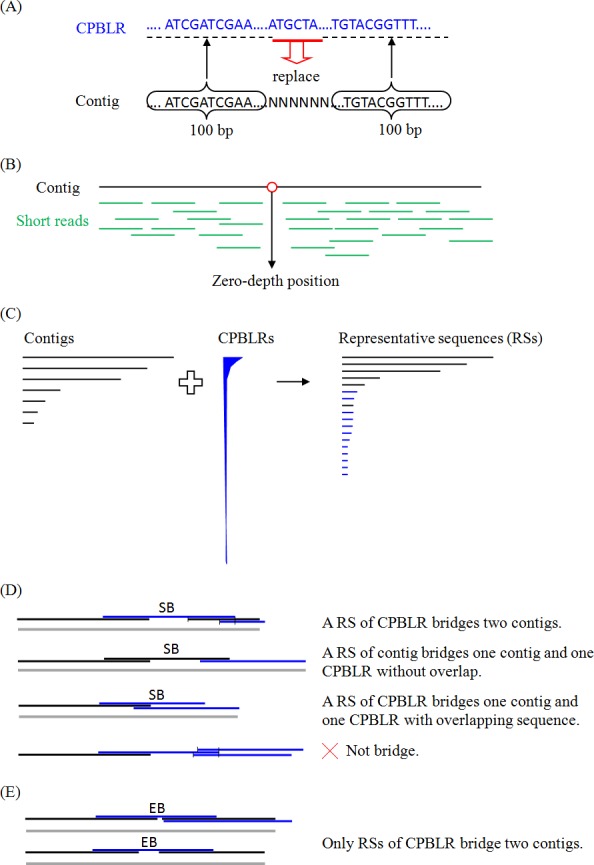
Schematic diagrams of the process flow used in Patch.(A) Gap-filling: a gap (with N’s) is replaced with the corresponding sequence (e.g., ATGCTA). (B) Splitting: A contig is split into two sequences at the zero-coverage position. (C) Representative sequence selection: representative sequences are selected from a modified assembly (contigs in black color) combined with all/15X CPBLRs (in blue color). (D) Strict bridging (SB): a representative sequence (RS) is used for bridging if it uniquely (i.e. the length of end-to-end alignments (as bounded by the vertical bars) is maximal and at least 1.25-fold larger than the secondary choice) aligns to two representative sequences (either one must be a black representative contig). The grey lines represent connected sequences. (E) Easy bridging (EB): a representative CPBLR (in blue) is used for bridging if it aligns to two individual contig sequences (in black) at either end.